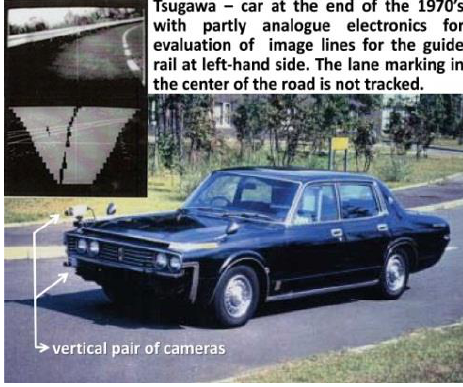
Figure 2. The first vision-guided road vehicle in the late 1970s, Japan [10].